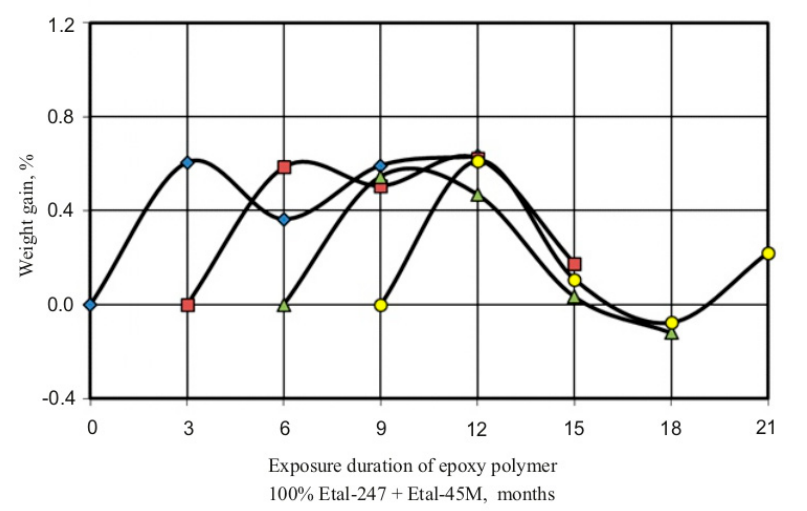
Figure 9. Change in the mass of samples of the composition of the epoxy polymer Etal-247 + Etal-45M